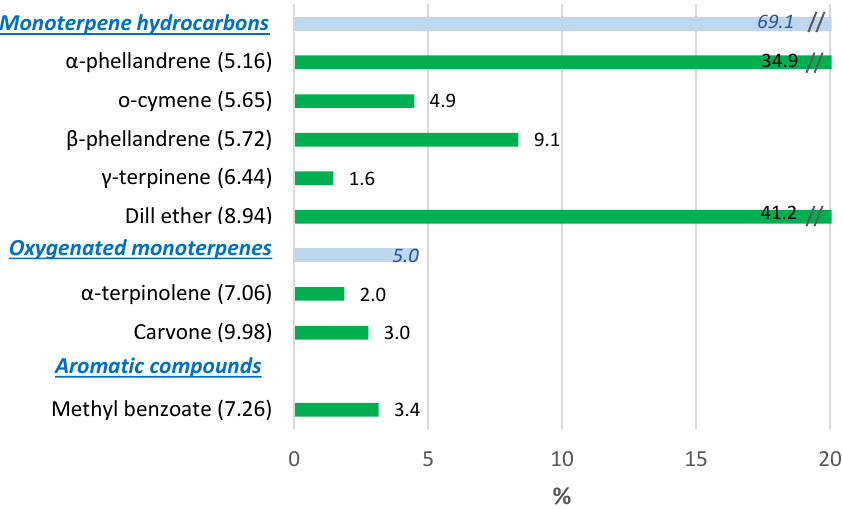
Figure 7. Volatile organic compounds (VOCs) profile of dill expressed as relative percentages. Bars represent relative VOCs contents (%). Values in parentheses represent VOCs retention times.